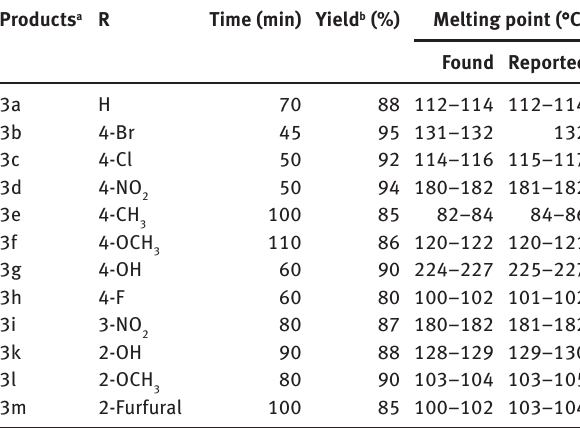
Table 1: Screening of catalyst MoO synthesis of 3b.